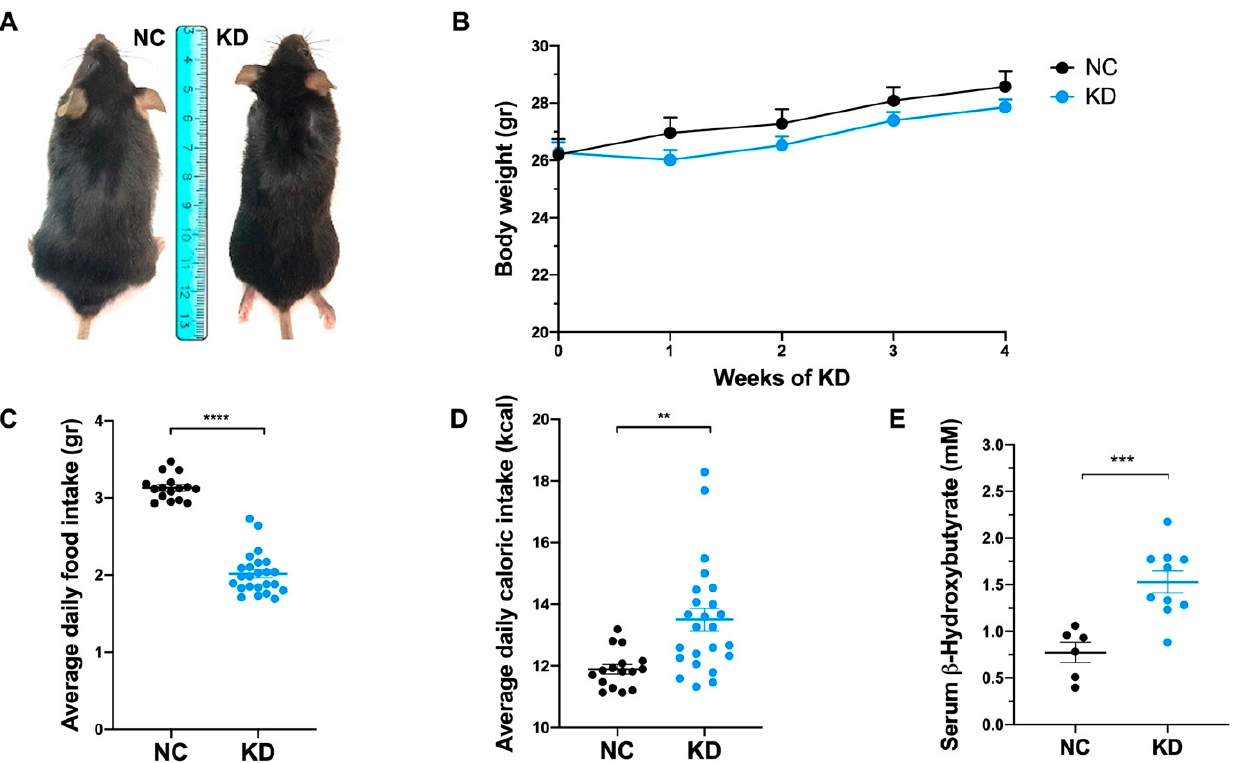
Figure 1. Ketogenic diet effects on body weight and food intake. ( A ) Representative photographs of mice under normal chow (NC) and ketogenic diet (KD) at the end of dietary treatment. ( B ) Body weight analysis during dietary treatment showing weight gain (g) of mice under NC (n = 8) and KD (n = 10). Data are expressed as mean ± SEM . ( C ) Scatter dot plot showing average daily food intake (g) of mice under NC and KD. Data are expressed as mean ± SEM. **** p < 0.001 . ( D ) Scatter dot plot showing average daily caloric intake (kcal) of mice under NC and KD. Data are expressed as mean ± SEM. ** p < 0.01. ( E ) Dot plot showing β HB concentration (mM) in serum from mice under NC (n = 6) and KD (n = 10) at the end of dietary treatment. Data are expressed as mean ± SEM. *** p < 0.005.